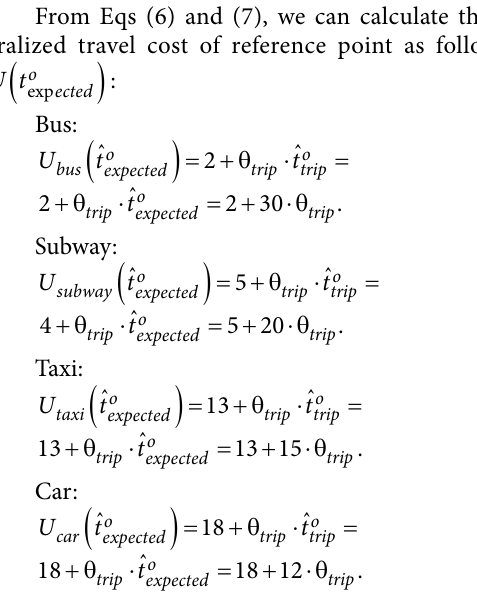
Table 3. Different levels of car owner’s mode choice